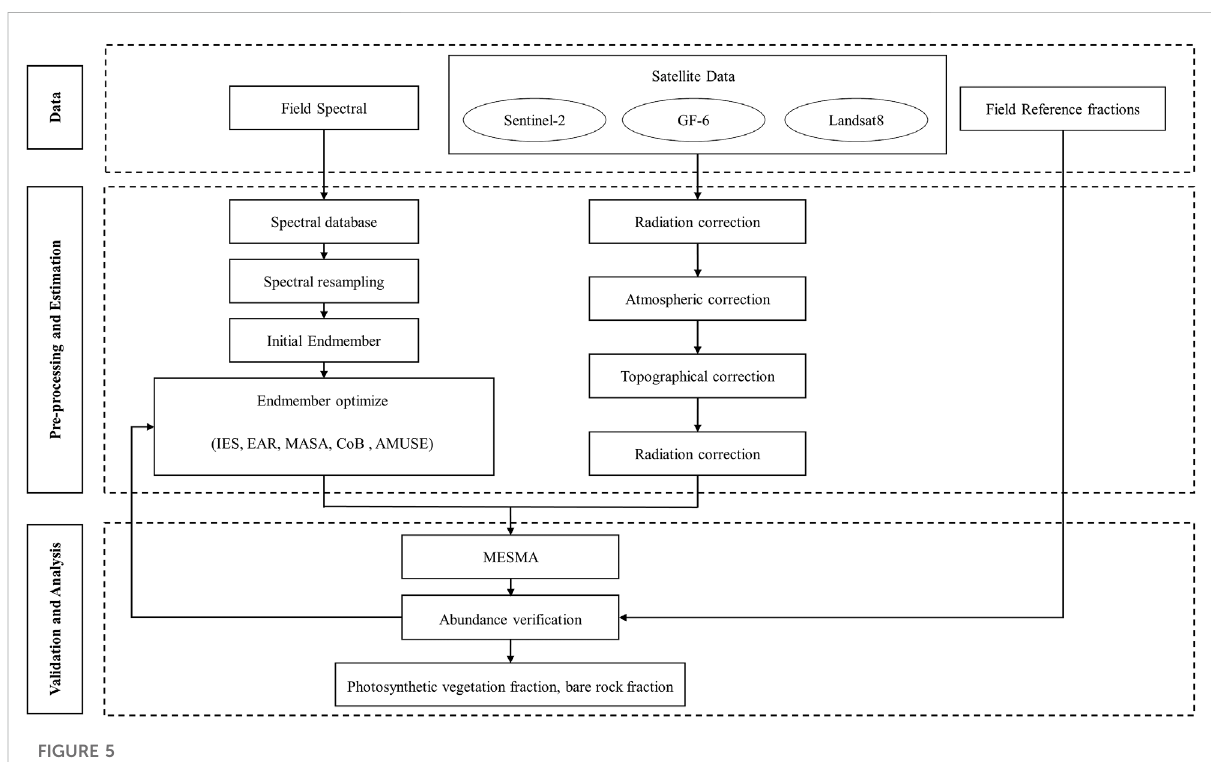
FIGURE 5 Work fl ow diagram of methodology and analysis